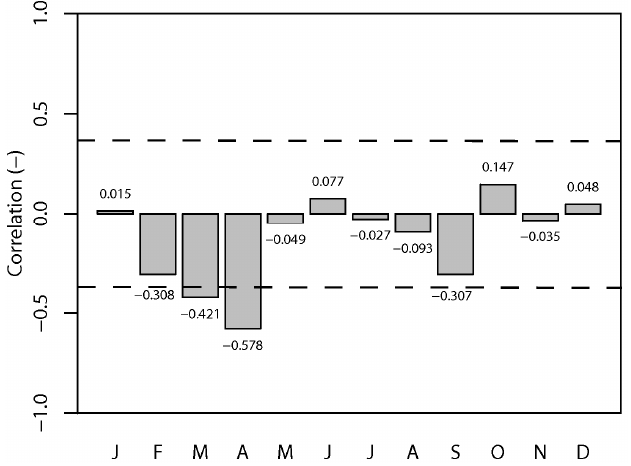
Figure 4. The correlation of concurrent monthly rainfall (mm/month) and Multivariate El Ninõ-Southern Oscillation (ENSO) Index (MEI) for Peninsular Malaysia. The dotted line indicates significance at 95% level.